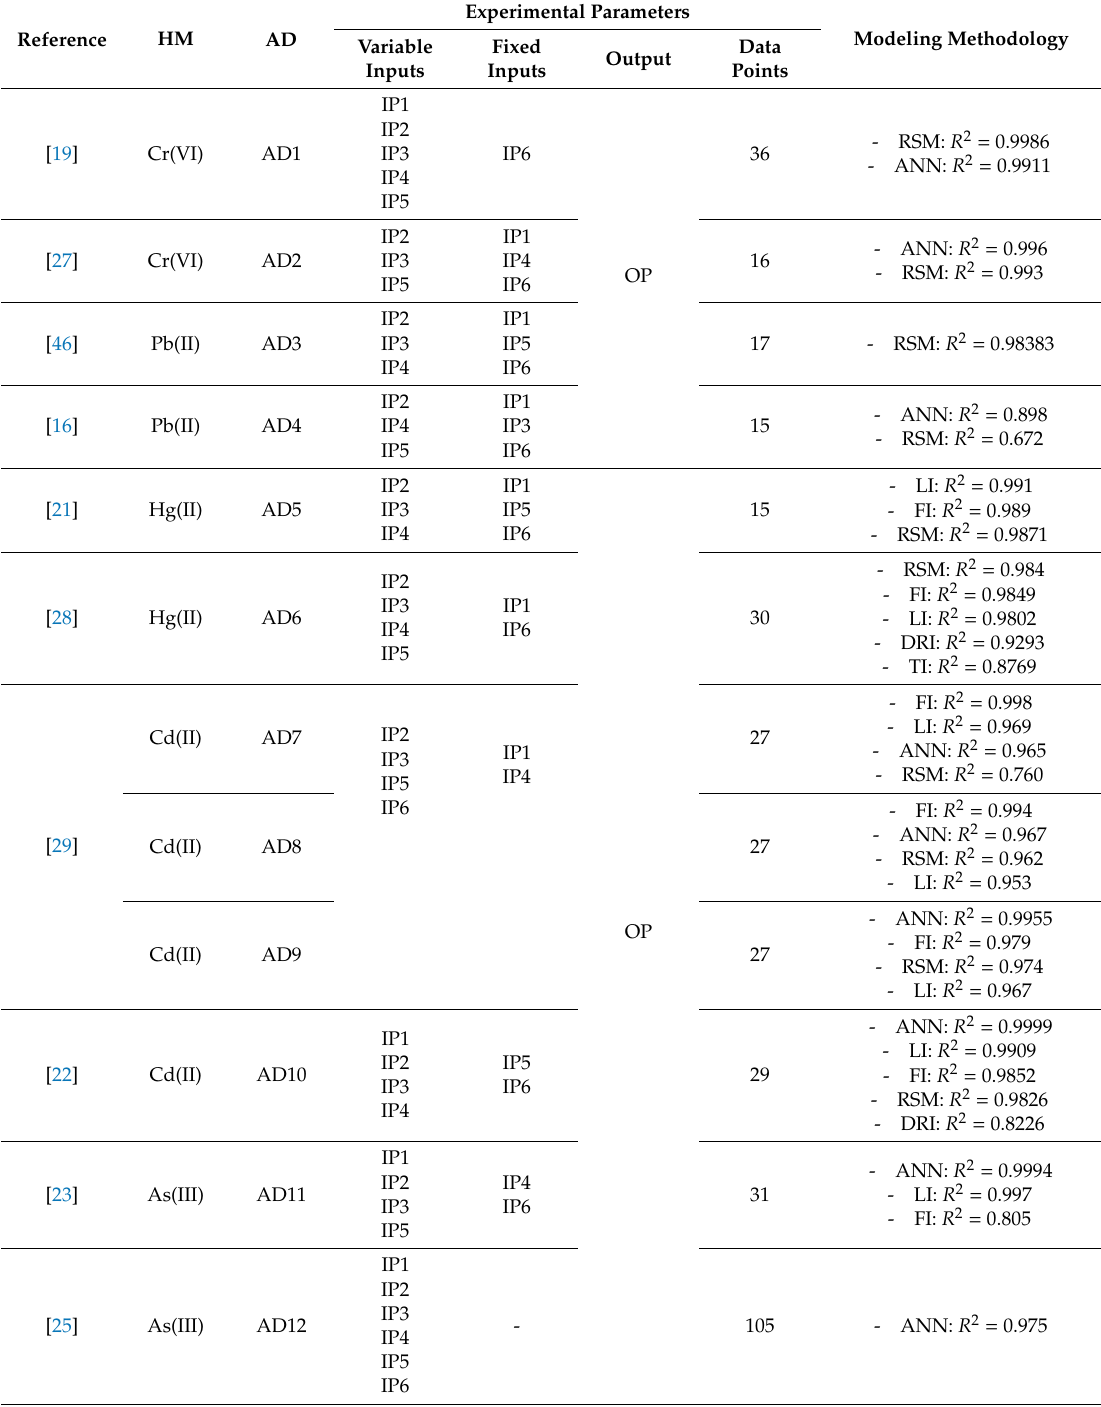
Table 1. Summary of the experimental